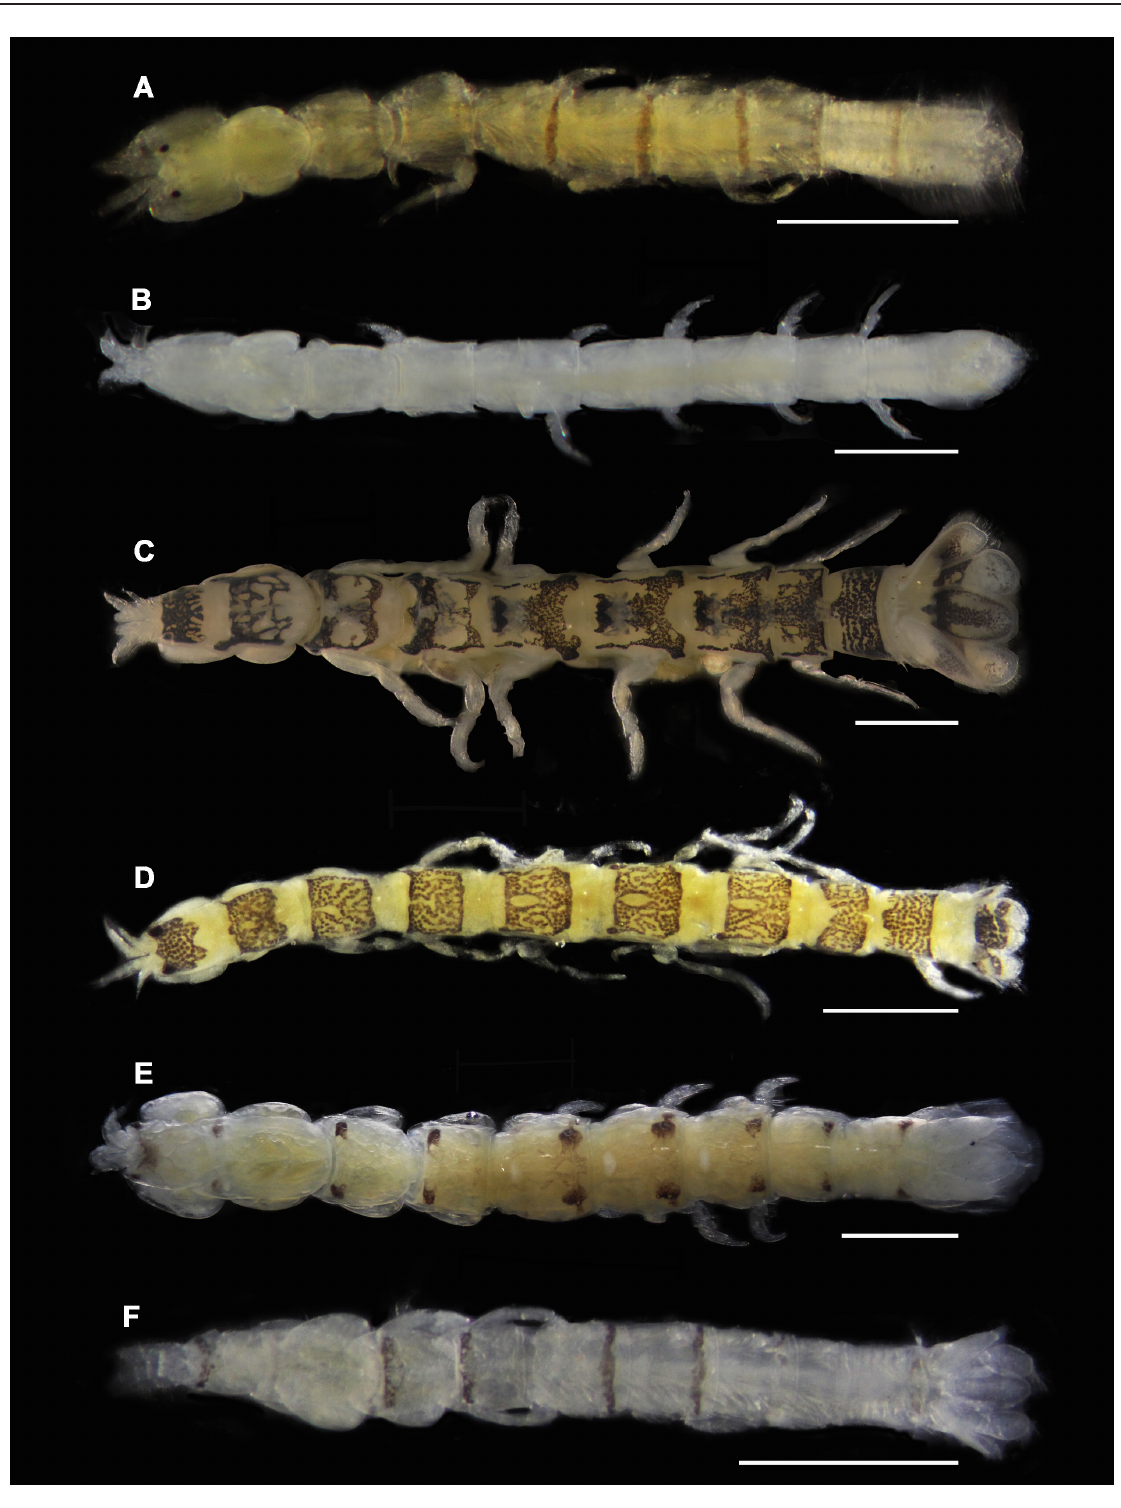
Fig. 20. A . Amakusanthura guerrerensis sp. nov., holotype, ♀ (UMAR-PERA 522). B . Cortezura caeca sp. nov., holotype, ♀ (UMAR-PERA 534). C . Mesanthura antenniformis sp. nov., paratype, ♀ (ovigerous) (UMAR-PERA 540). D . M. estacahuitensis sp. nov., holotype, ♀ (UMAR-PERA 547). E . Skuphonura oaxaquensis sp. nov., holotype, ♀ (UMAR-PERA 548). F . Tinggianthura mexicana sp. nov., holotype, ♀ (UMAR-PERA 561). Scale bars = 1